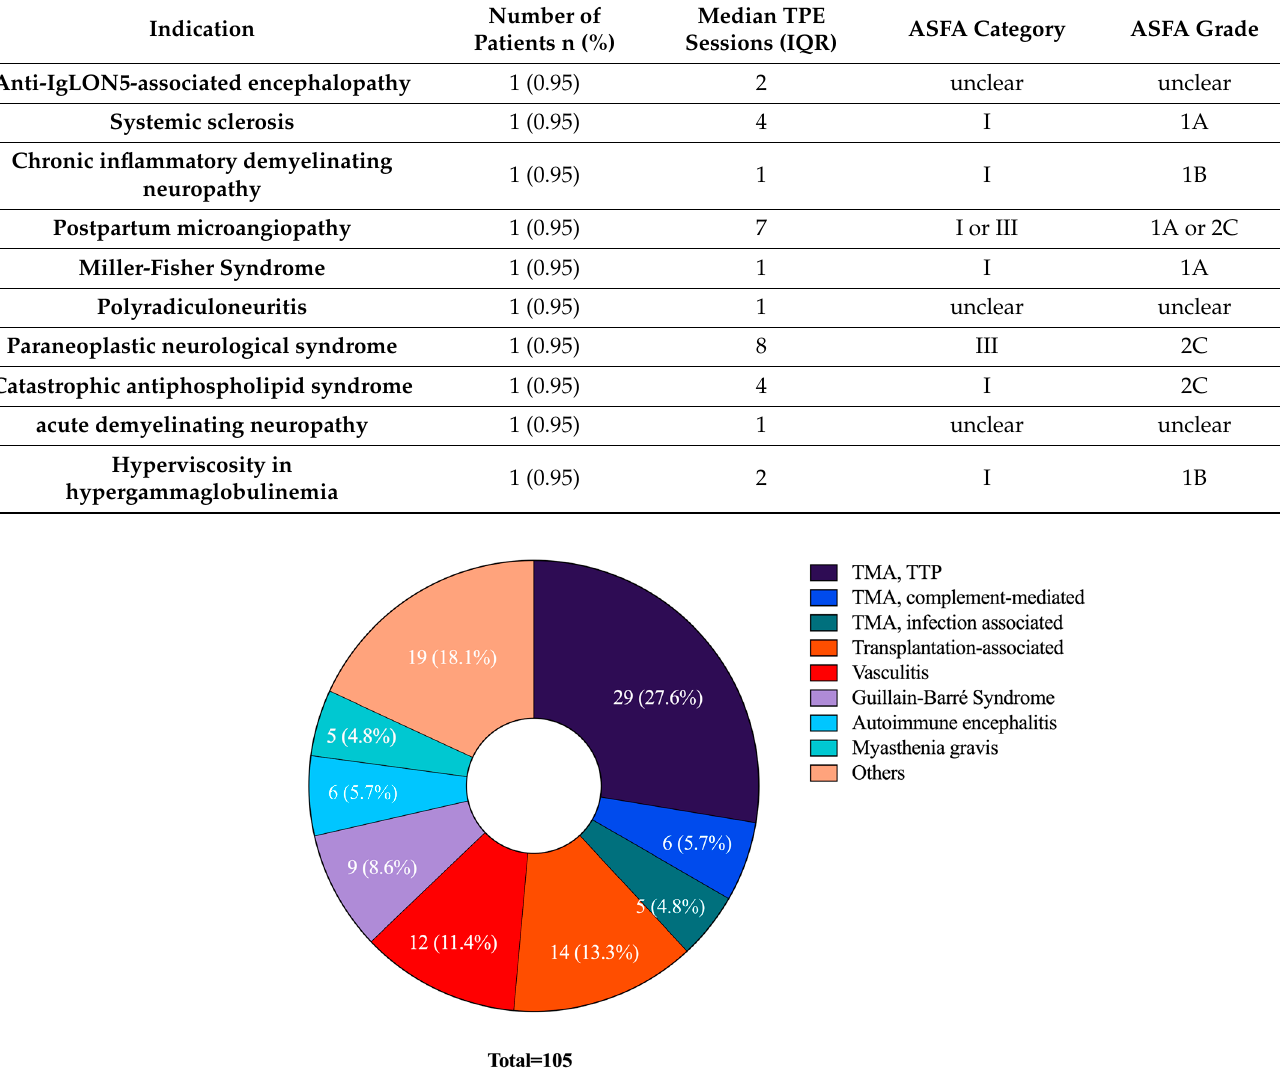
Figure 1. Distribution of all indications for TPE in the ICU setting. The indications (equal to afflicted patients) are shown in absolute numbers and percent of the total number of patients affected (n = 105). Abbreviations: TTP—Thrombotic thrombocytopenic purpura, TMA—Thrombotic microangiopathy. Others: acute liver failure (n = 2), macrophage activation syndrome (n = 1), progressive